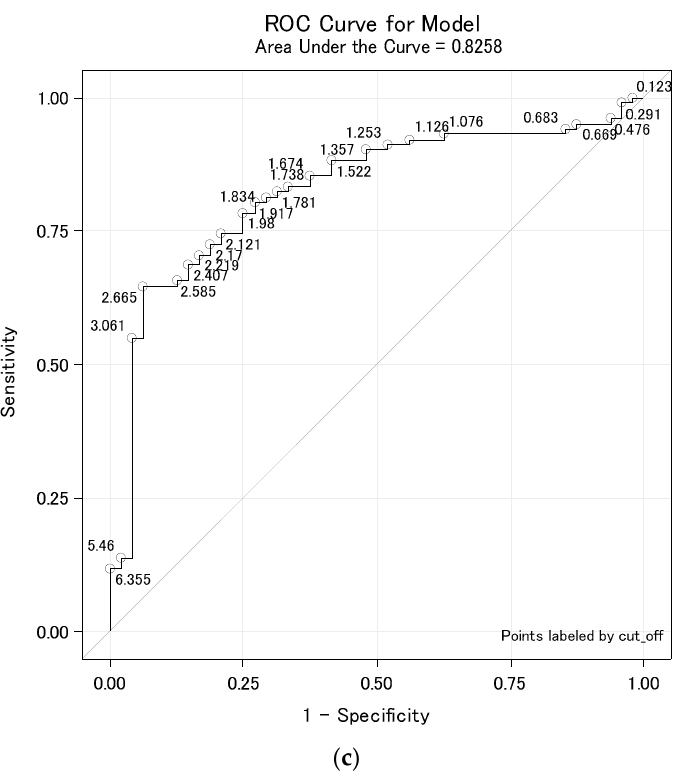
Figure 4. ( a ) Diasorin cut-off for titer 160. ( b ) Beckman Coulter cut-off for titer 160. ( c ) Euroimmun cut-off for titer 160. Legend: ROC curve for Diasorin, Beckman Coulter and Euroimmun, titer <160 vs. ≥ 160 where the ROC curve is labeled by all possible cut-offs. These ROC curves are already typical. Thus, specificity can be targeted as close to 95%. For cut-off values for individual methods, see Table 4.